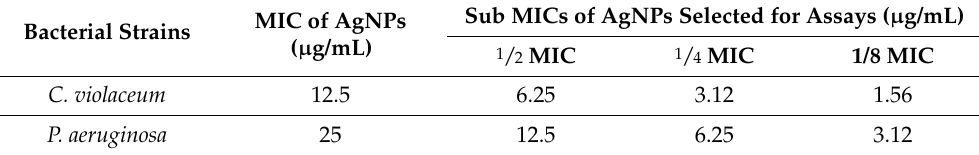
Table 1. AgNPs minimum inhibitory concentrations against pathogenic bacteria.